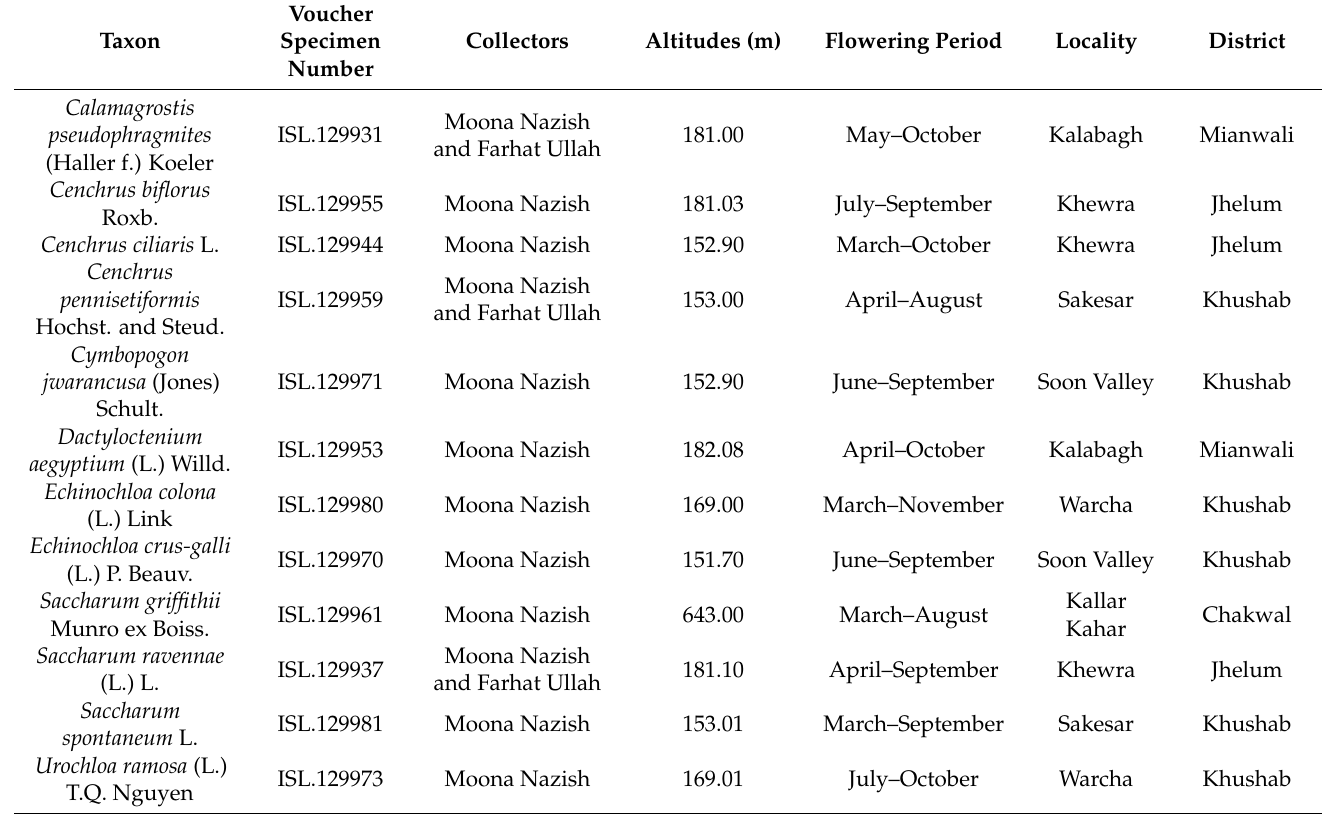
Table 4. Taxon Sampling and deposition in the